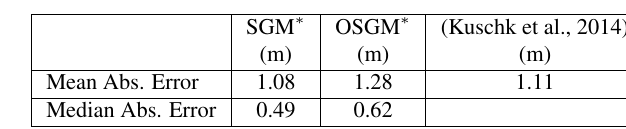
Table 1: Error values from DSM differences. (* The error values have been computed only for AOI) Figure 3: Left: DSM from Laser scanning Middle: DSM com- puted from SGM Right: Difference between the two DSM